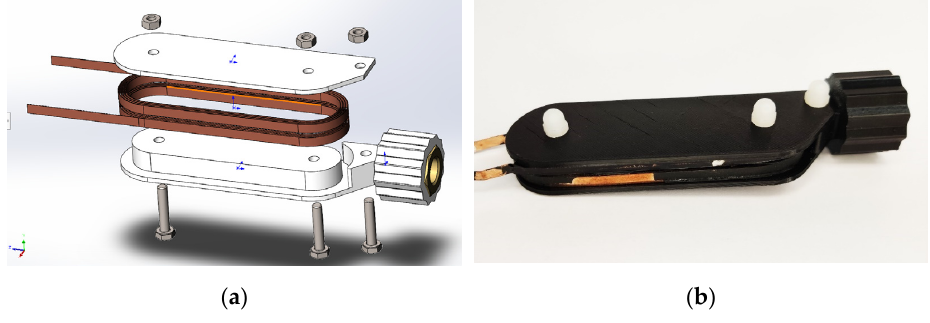
Figure 4. HTS coil in holder. ( a ) Model; ( b ) appearance of the sample. The result of the computed tomography method is a tomogram—a three-dimen- sional voxel image with a resolution of 1024 × 1024 × 1024 voxels (Figure 5a). It is supposed that data processing is carried out along the rotation axis. To do this, the data are presented as a set of 1024 slice images with a resolution of 1024 × 1024 pixels, where each of the images is a slice of the coil (Figure 5b). A tomogram with such a resolu- tion displays a space of 12.3 × 15.6 × 15.6 mm in size, which contains a section of the coil. To obtain data on the entire linear part of the coil and ensure that the received data overlap by 2 mm, it is necessary to study 9 areas for each of the sides. Thus, for the coil, 1024 × 9 × 2 = 18,432 slice images are obtained. Since the processing of such a volume of data can take a significant time and there is no need to measure the gaps every 12 μ m, it was de- cided to measure the gaps in 1 mm steps, which corresponds to 13 slices (positions at 0, 1, 2, …, 12 mm) on each tomogram and 13 × 9 × 2 = 234 slices in total.